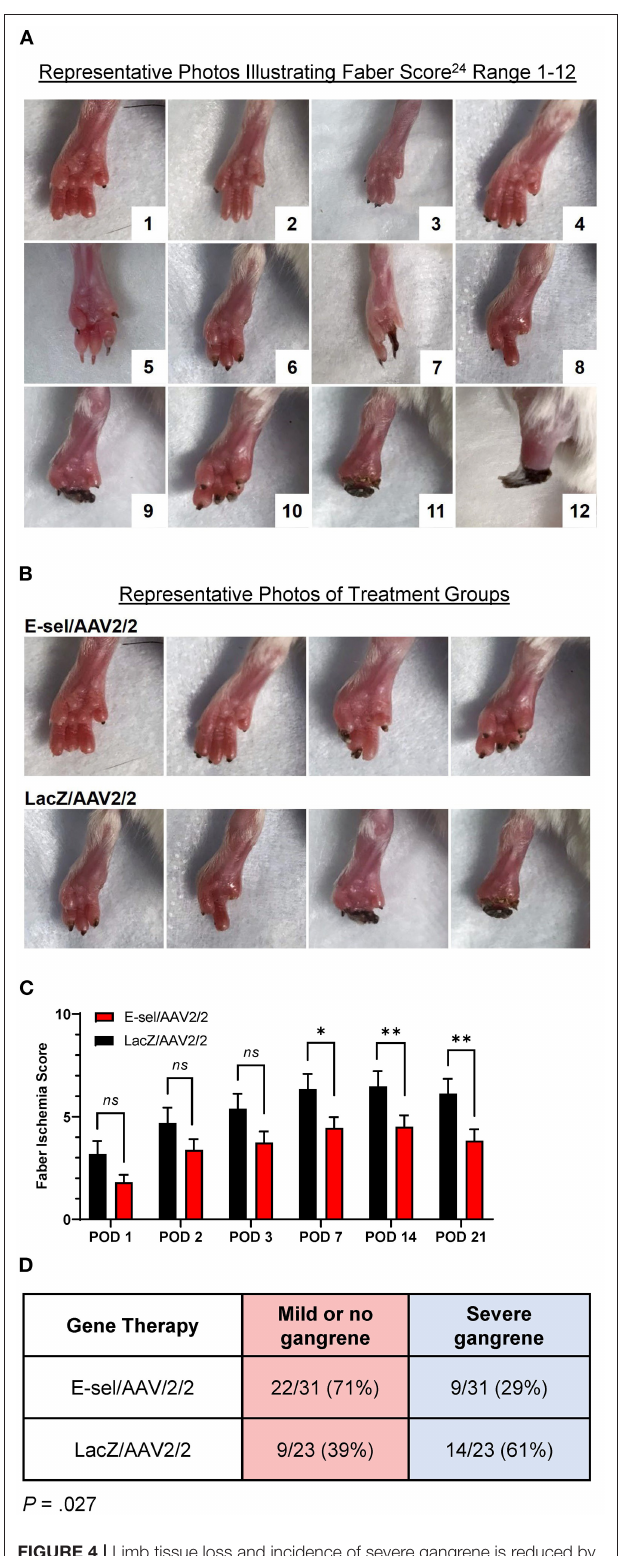
FIGURE 4 | Limb tissue loss and incidence of severe gangrene is reduced by E-sel/AAV2/2 gene therapy. (A) Representative photos illustrating range of